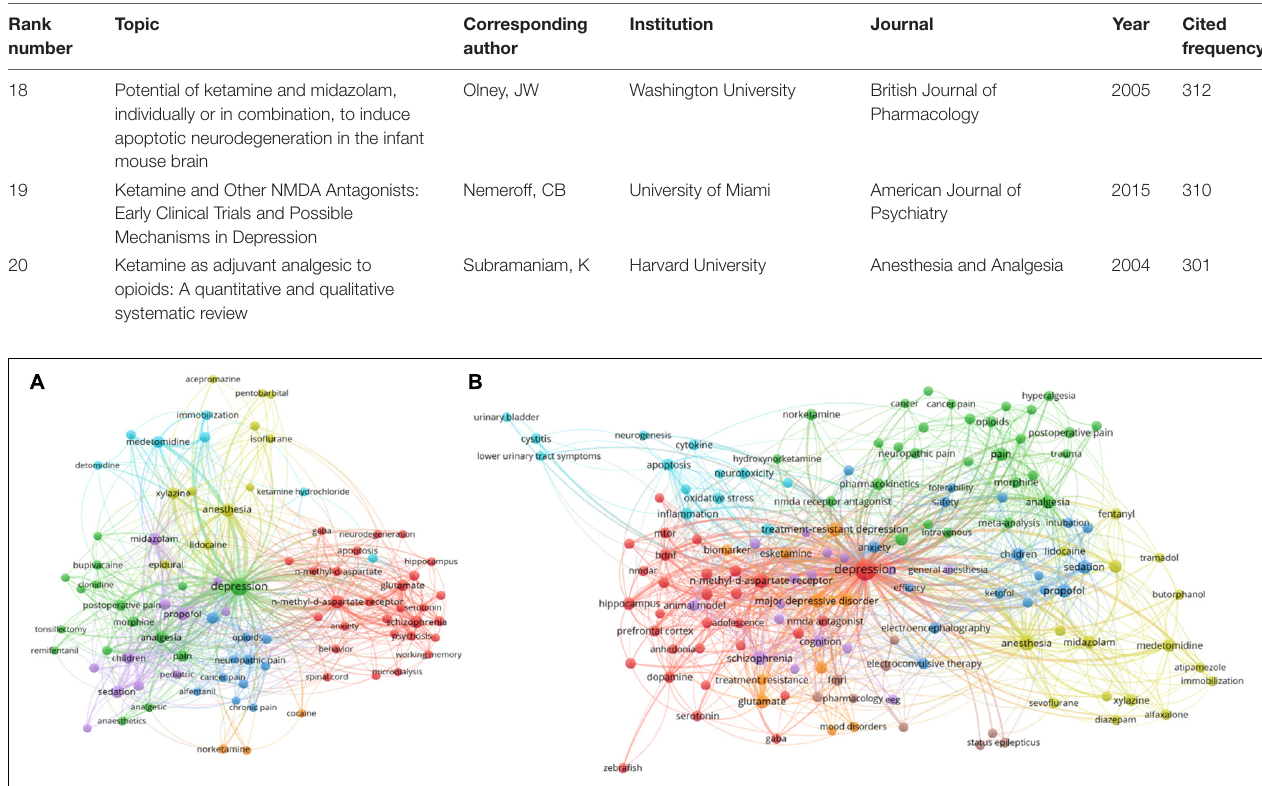
FIGURE 6 | A summary of the hotspot trends of articles on ketamine from 2001 to 2020. The size of the circles and the thickness of the line represent the frequency of co-occurring keywords. (A) Hotspots of articles published on ketamine from 2001 to 2010. (B) Hotspots of articles published on ketamine from 2011 to